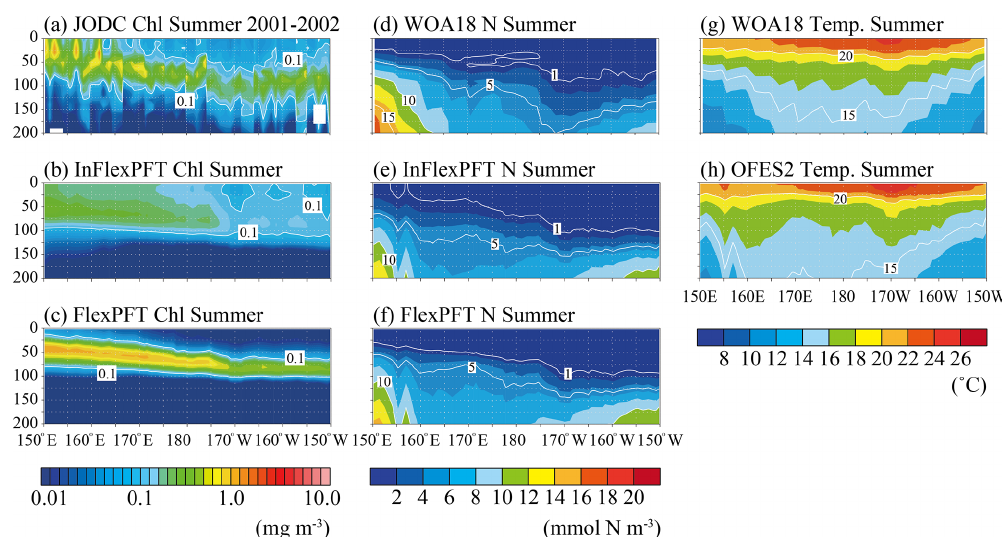
Figure 3. Comparison of the vertical distributions of (a) – (c) summer (June, July and August) Chl concentration (mgm − 3 ), (d) – (f) summer N concentration (mmolNm − 3 ), and (g) – (h) summer T ( ◦ C) along the location of the white crosses (east–west section) in Fig. 1. Panel (a) shows in situ observation data collected by the JODC in the summer in 2001–2002. Panels (d) and (g) show data for the climatological summer from WOA18. (b) , (c) , (e) , (f) , and (h) show the models’ average values for the summer during the 2000–2019 period. The white area in (a) represents missing